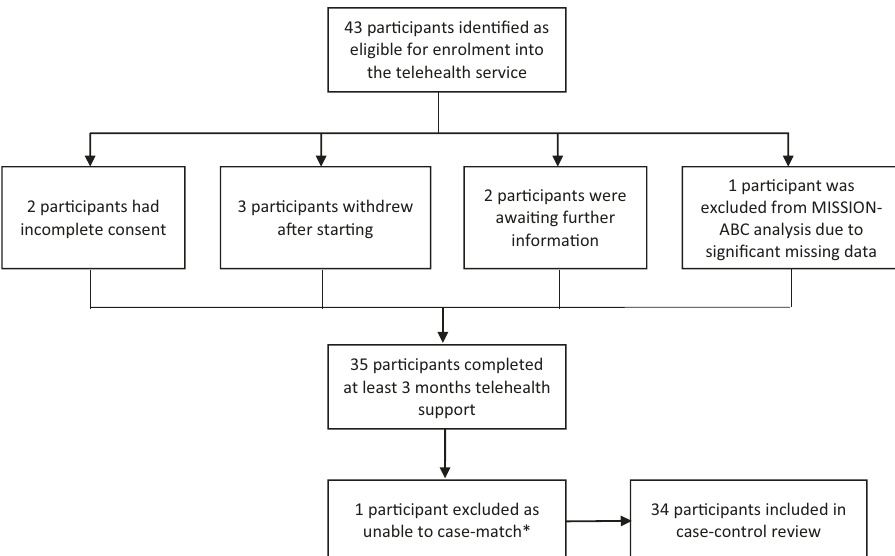
Fig. 1 Flow-chart demonstrating participant recruitment. Following a review in a MISSION-ABC clinic, one participant did not meet the inclusion criteria of a con fi rmed diagnosis of asthma or